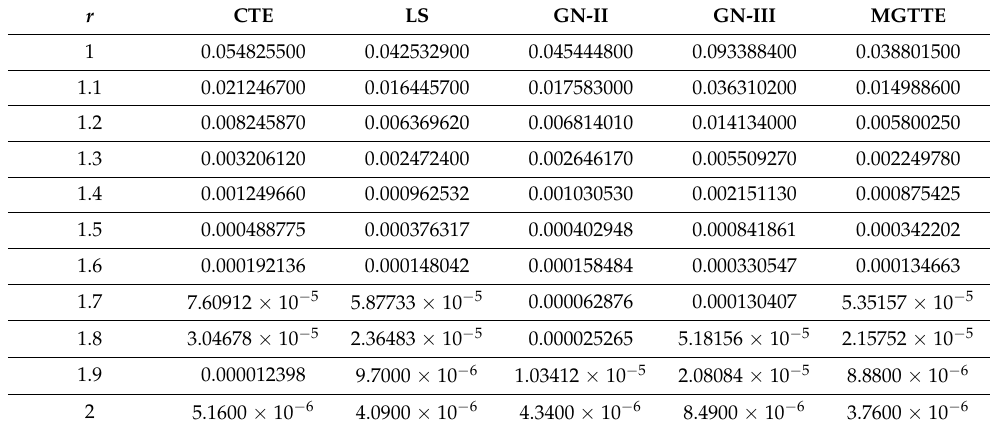
Table 6. The induced electric field, E , versus different models of thermoelasticity.